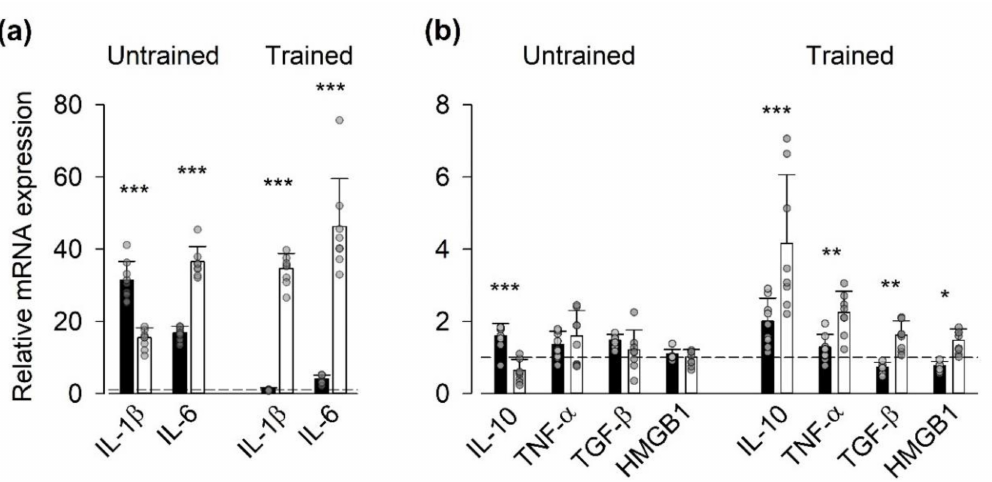
Figure 1. Vitamin treatment blunted the exercise-induced increase in mRNA expression of genes encoding for inflammatory mediators in the trained state. Data (mean ± SD) are expressed as the ratio of mRNA expression 1 h after to that before the first (Untrained) and last (Trained) SIT sessions. Genes showing large exercise-induced e ff ects ( a ) and more moderate e ff ects ( b ). Vitamin group (black bars, n = 9); placebo group (white bars, n = 7); dashed lines indicate no di ff erence between before and after exercise (i.e., relative mRNA expression = 1). Data from each participant are shown as grey circles. Two-way repeated measures ANOVA showed a general group di ff erence ( p < 0.001) in the trained state both in ( a ) and ( b ). Di ff erence between vitamin and placebo groups in relative mRNA expression of individual genes: * p < 0.05, ** p < 0.01, *** p <